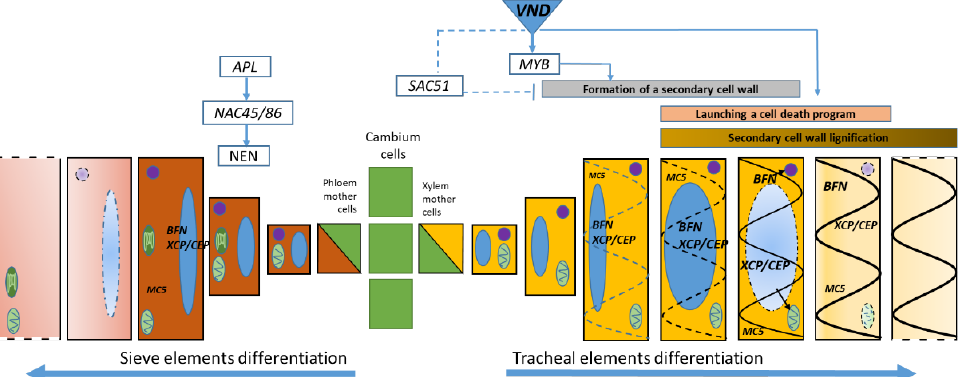
Figure 7. The cytology and molecular genetic control of differentiation of tracheal elements of the xylem (according to Escamez and Tuominen [26] with changes) and sieve elements of the phloem. The initial stages of xylem differentiation are regulated by the transcription factor VASCULAR-RELATED NAC-DOMAIN (VND), which, through the MYB (my elob lastosis) protein family, triggers the synthesis of secondary cell wall components or inhibits this process by triggering the SAC51 (SUPPRESSOR OF ACAULIS 51) suppressor. In addition, VND positively regulates the expression of genes encoding BFN, CEP/XCP, and MC, which are involved in the proteolysis of cell structures under PCD. Phloem cell differentiation begins under the action of the ALTERED PHLOEM DEVELOPMENT ( APL ) gene, whose downstream targets are NAC45/86 (NO APICAL MERISTEM, ATAF1, ATAF2, and CUP-SHAPED COTYLEDON 2) and nucleases of the NEN family [12]. Our study shows the possible involvement of genes of the BFN family in the process of differentiation of sieve elements of the phloem.